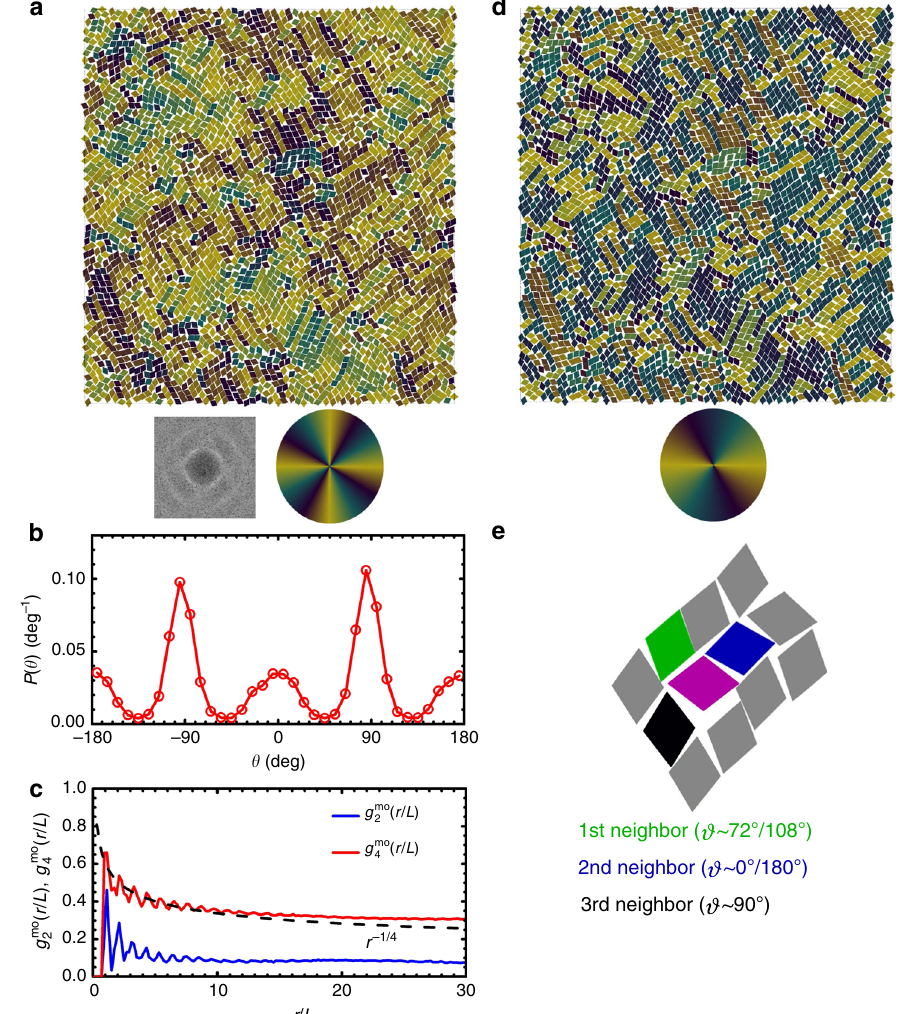
Fig. 6 An example of a T2 phase ( α = 72°, ϕ A = 0.773, NPT ensembles). a A color-coded con fi guration using a color wheel with fourfold rotational symmetry. Bottom left: the fast Fourier Transform (FFT); Bottom right: color wheel used for color-coding particle orientations. b Probability density P ( θ ) of single-particle orientational angle θ . c Two- and fourfold molecular-orientational correlation functions g 2 mo ( r/L ) and g 4 mo ( r/L ). Dashed line is ∝ r − 1/4 . d The same con fi guration as in a but color-coded using a color wheel with twofold rotational symmetry. Bottom: color wheel used for color-coding particle orientations. e A representative con fi guration of twinning structure showing ϑ ~ 90° between the target particle (magenta color) and its third nearest neighbor (black color) in α = 72° system. The emergent domain structures seen in parts a and d can be interpreted morphologically as